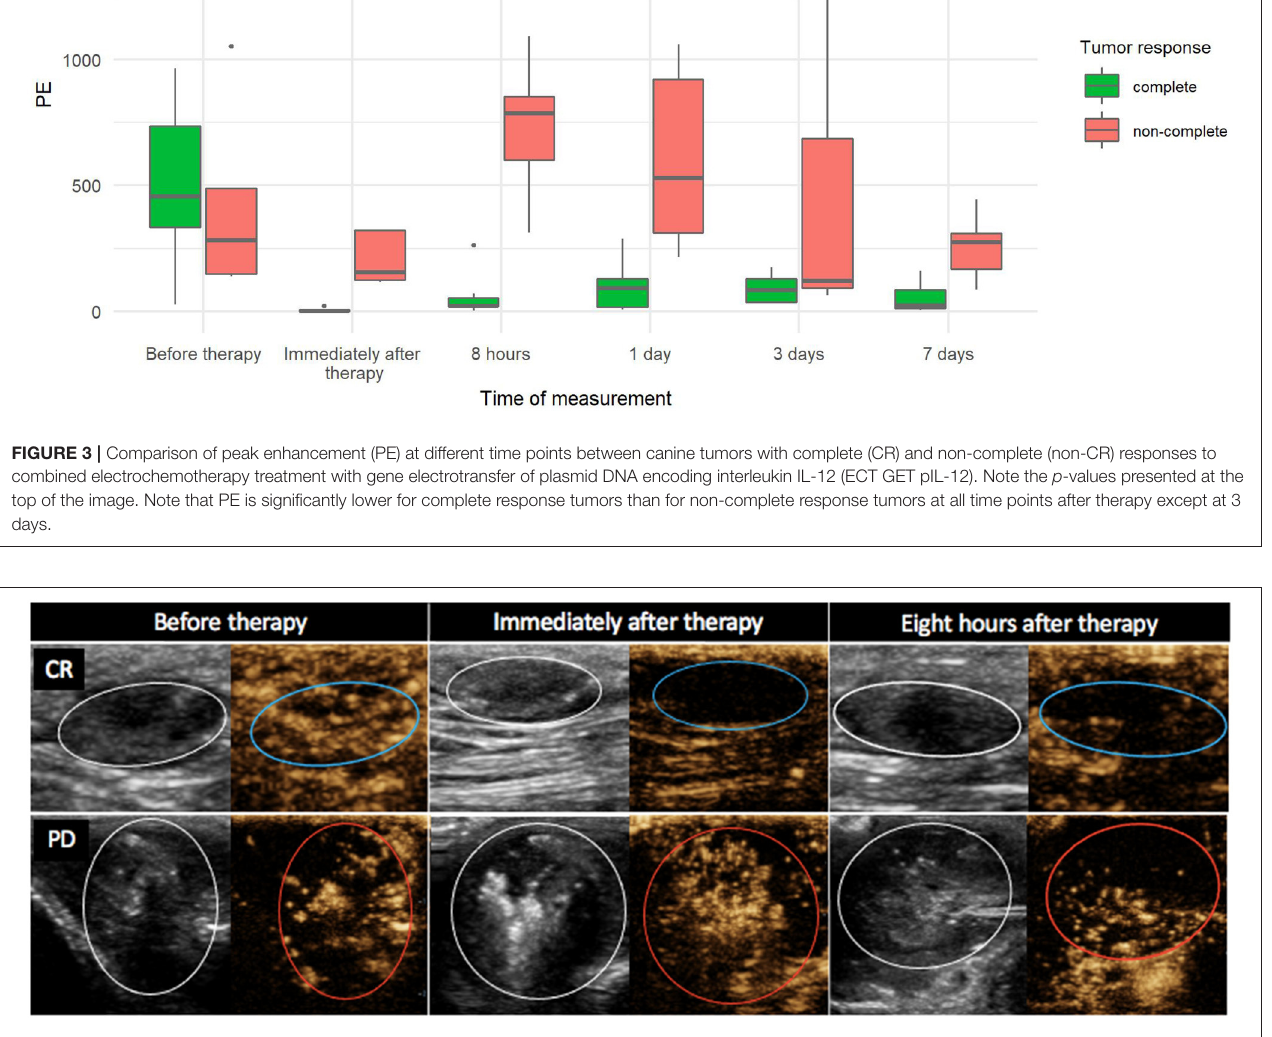
FIGURE 4 | Contrast-enhanced ultrasound images (B mode image to the left and non-linear contrast mode to the right of each image) of two mast cell tumors in dog 4. Images were obtained 20s after contrast administration at different time points after electrochemotherapy (ECT) combined with gene electrotransfer of plasmid DNA encoding interleukin IL-12 (GET pIL-12) as noted at the top of the figure. Note the difference between tumors with complete response (CR) and tumors with progressive disease (PD) after therapy. Non-CR tumors (red circles) are filled with microbubbles, whereas CR tumors (blue circles) show no contrast enhancement immediately and 8h after